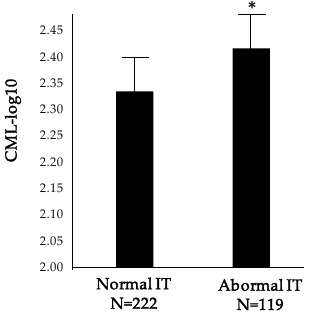
Figure 1. Comparison of baseline serum levels of N-epsilon-carboxy methyl lysine (CML; log-transformed) between patients with normal and abnormal implicit time (IT; IT ≥ 37.43 milliseconds). * p = 0.009. AU: arbitray units.